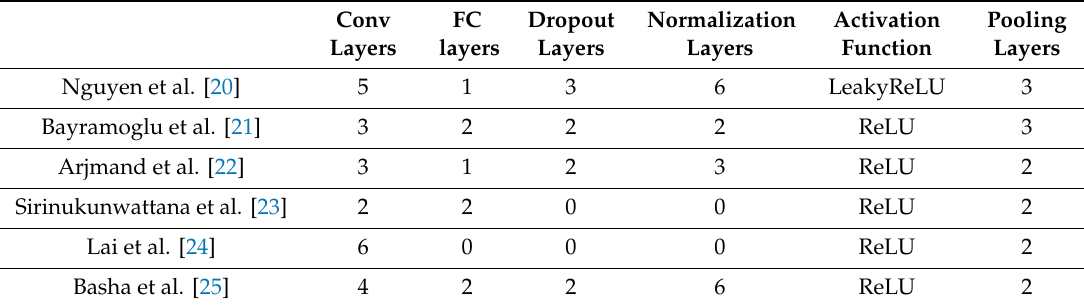
Table 2. Information related to the architectures defined in the papers identified in Table 1.